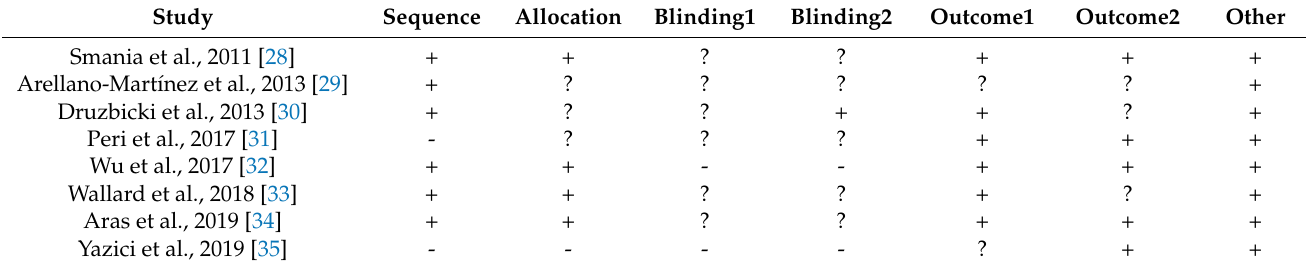
Table A2. Risk of bias: Cochrane’s collaboration tool for assessing risk of